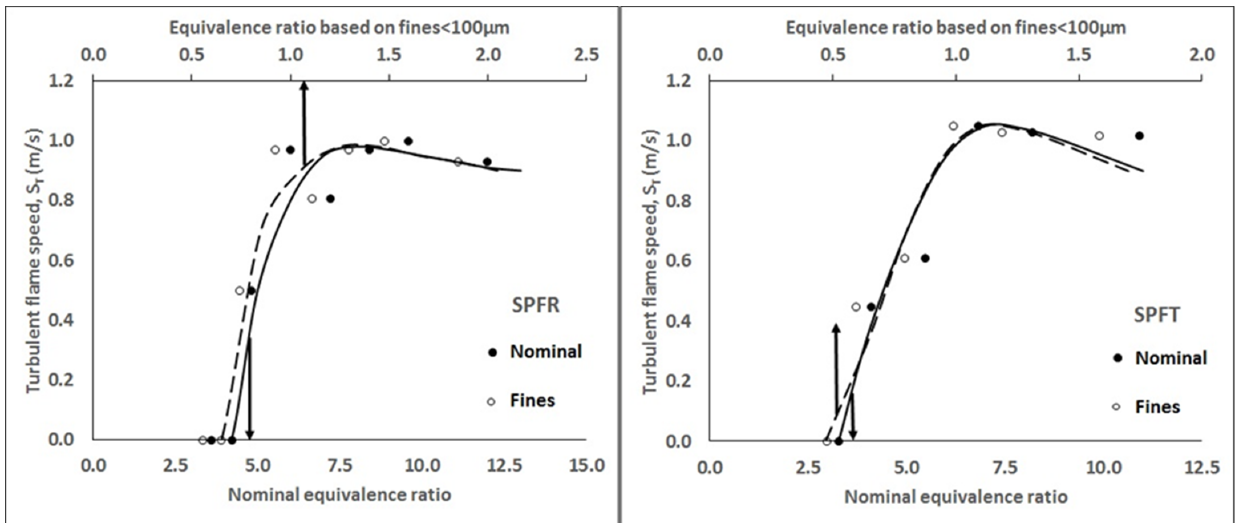
Figure 6. Turbulent flame speed (ST) vs. Equivalence ratio (Ø) for raw SPF and torrefied SPF wood mixture.